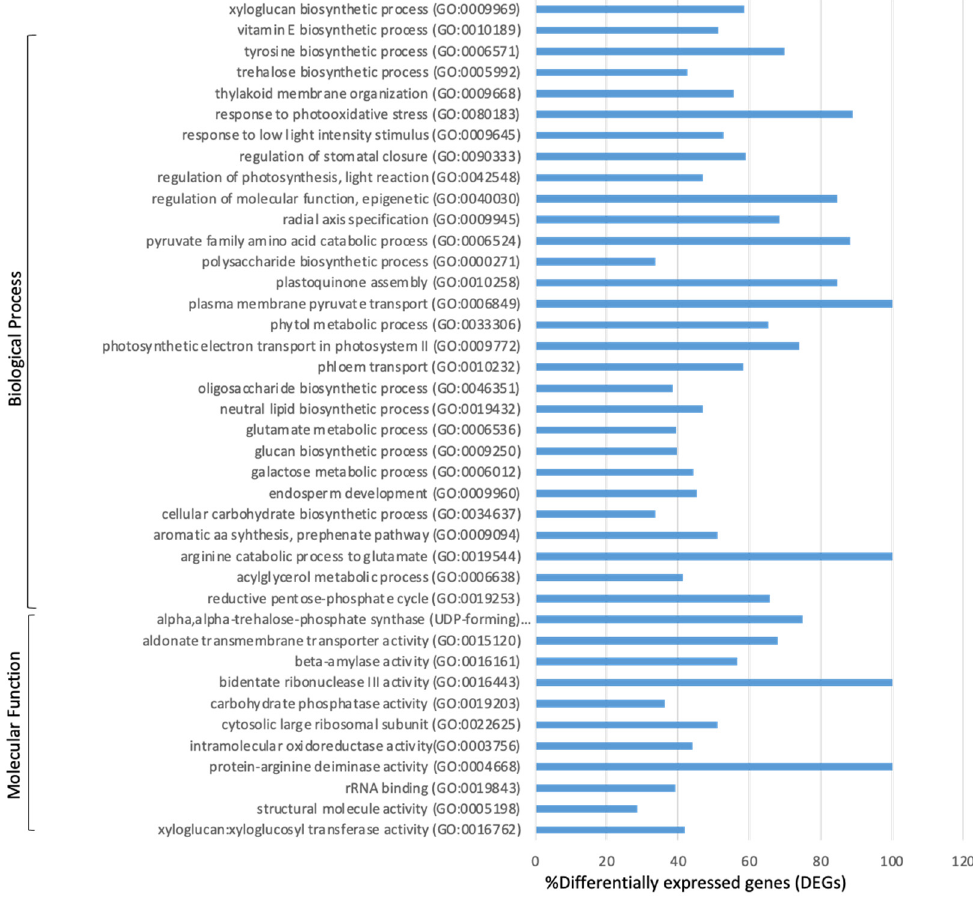
Figure 3. Enrichment of GO terms in quinclorac-resistant Echinochloa colona (ECO-R) after quinclorac treatment. This enrichment response in ECO-R is relative to the treated susceptible genotype (ECO-S) transcriptome, and the percentages of differentially expressed genes within each GO term are presented. Table 1. Comparison of putative genes (with p -value < 0.01, FDR < 0.05) involved in detoxification after quinclorac treatment. The increase in expression of putative genes in quinclorac-resistant Echinochloa colona (ECO-R) compared to the susceptible genotype (ECO-S) 24 h after treatment. ECO-R ECO-S Gene